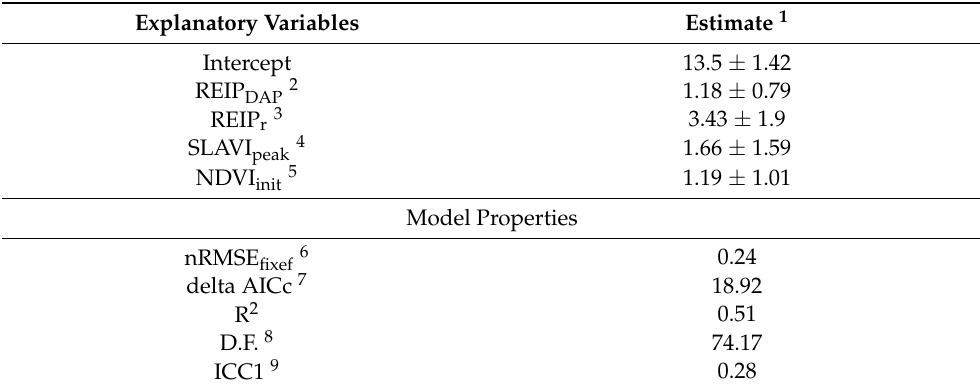
Table 7. Estimated coefficients for explanatory variables of potato stem density and the estimated spatial autocorrelation